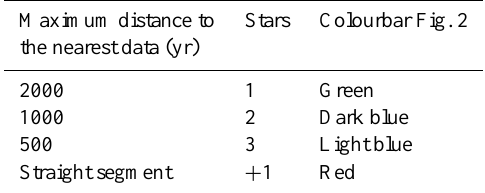
Table 2. Classification of sample age uncertainty from the star clas- sification system (Adapted from Giesecke et al.,